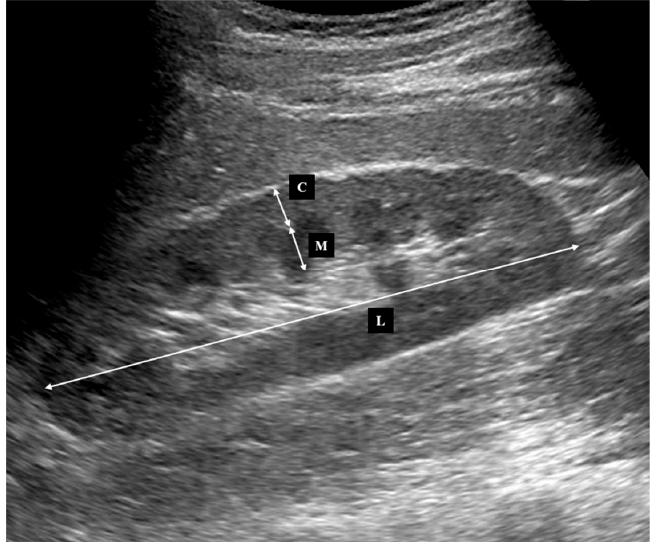
Figure 2. Longitudinal image of ultrasonography for the measurement. C, cortical thickness; M, medullary thickness; L, length.